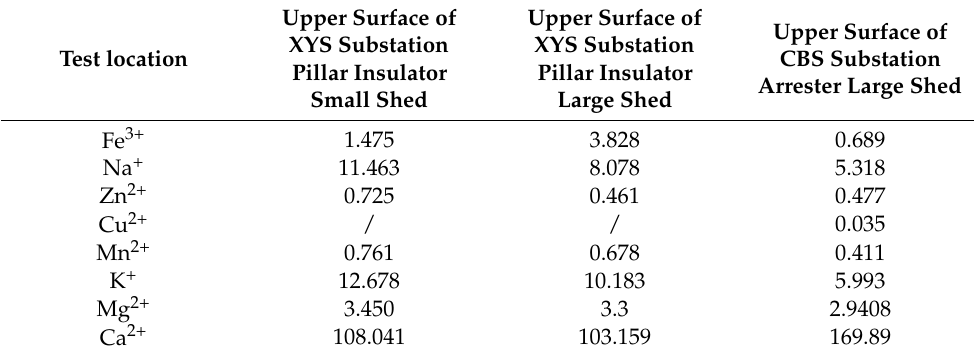
Table 7. The concentrations of anions in the contamination solution